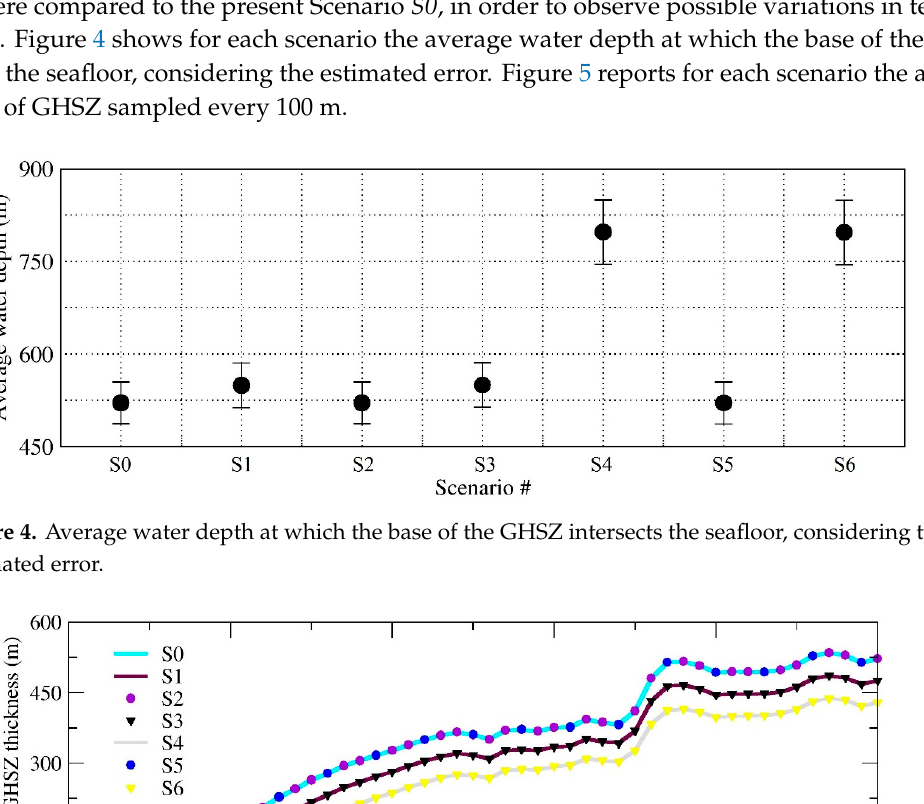
and a mean hydrate saturation of 3% according to the minimum value proposed by [21,30].